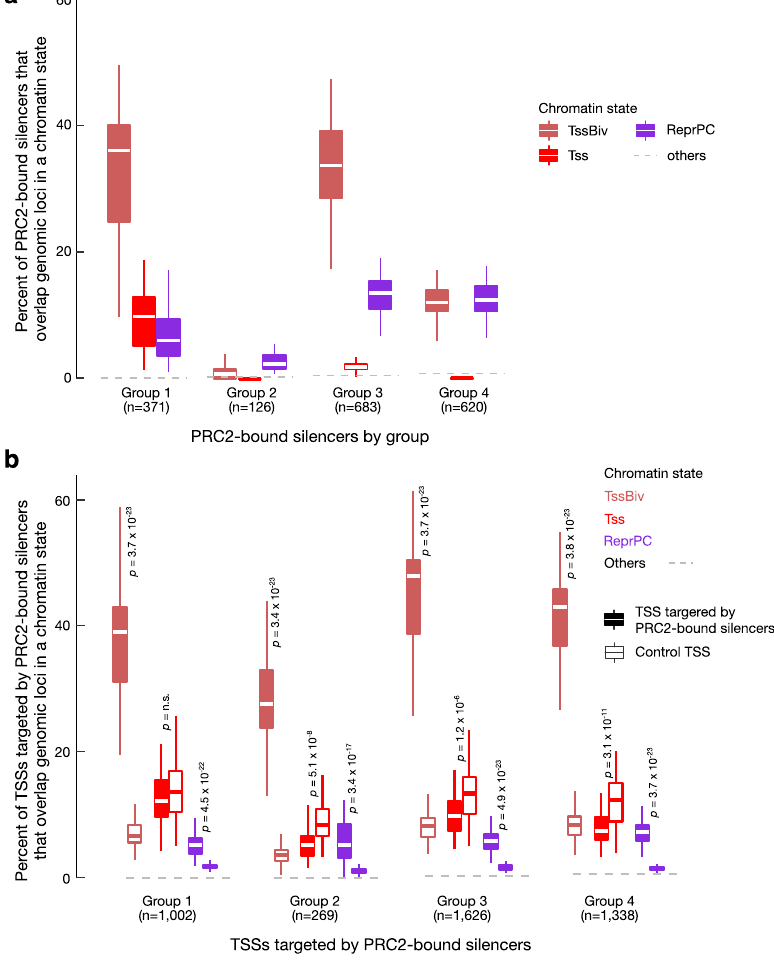
Fig. 6 PRC2-bound silencers and their target TSSs are enriched in the TssBiv and ReprPC states. a Percentage of PRC2-bound silencers whose centers overlap a genomic bin assigned to the TssBiv, Tss, ReprPC, or other chromatin states. Silencers were divided into four groups by Ngan et al. 33 according to H3K27ac signals in mouse fetal tissue biosamples. To normalize for the differential genomic coverage of the chromatin states, matching numbers of genomic bins were randomly drawn from the other states to match the number of genomic bins in TssBiv in each biosample. States are colored as in Fig. 1b and the average of the other 15 states is shown as a gray dashed line. b Same as a but for the TSSs targeted by the PRC2-bound silencers de fi ned by Ngan et al. 33 . We randomly selected TSSs with the same distance distribution from PRC2-bound silencers as a control (open